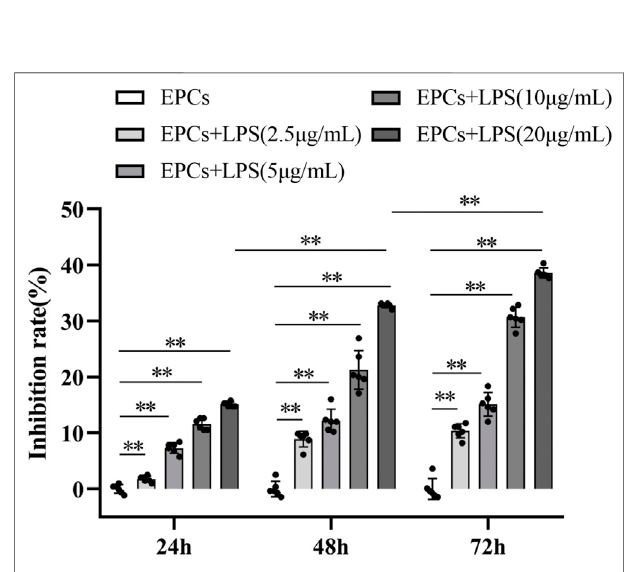
FIGURE 2 | EPCs viability was reduced after being induced by LPS. EPCs were treated with different concentrations (2.5 μ g/ml, 5 μ g/ml, 10 μ g/ ml, 20 μ g/ml) LPS for different time (24, 48, 72 h). Cell viability was measured by MTT assay. Data are presented as mean ± SD ( n = 6); ** p < 0.01.